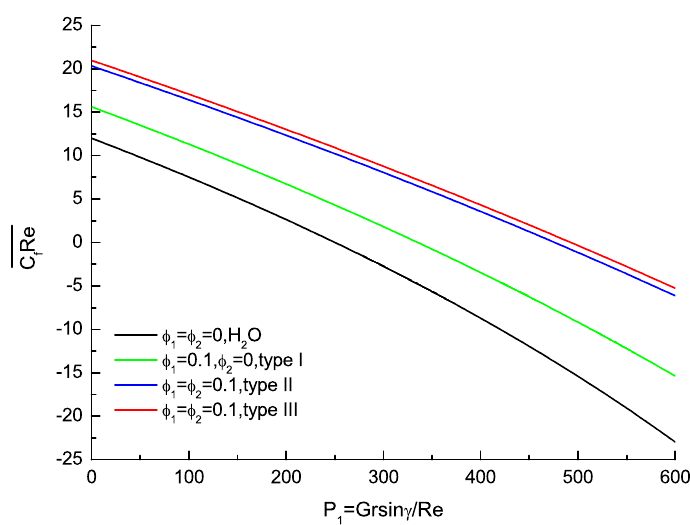
Figure 5. Variation of average C f Re with P 1 when Re = 10,Pr = 1 and Gr = 3000.